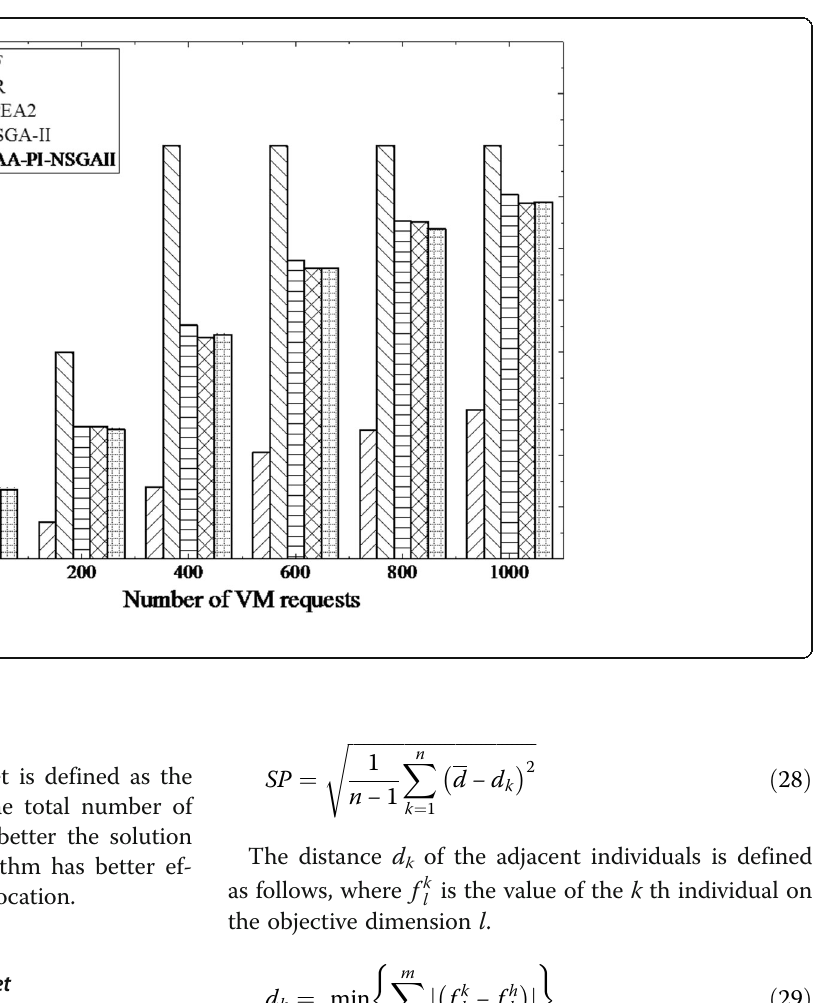
The time of VM resource allocation includes the solving time of the RAA-PI-NSGAII algorithm, the VM waiting time in the queue and the VM creation time. The total VM waiting time and creation time of all VMs are